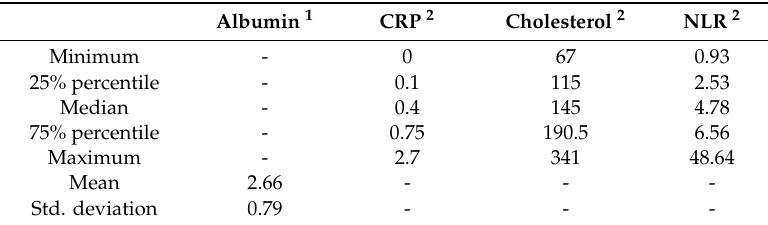
Table 1. Descriptive statistics of the continuous variables included in the study (albumin, C-reactive protein (CRP), cholesterol, and NLR).